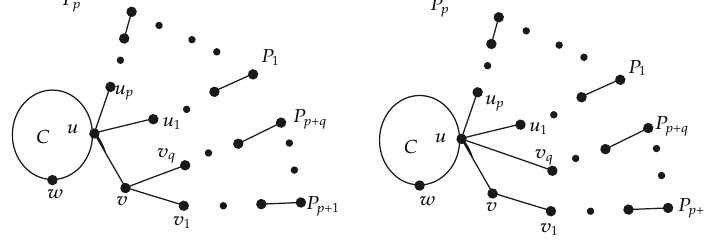
Figure 3: Example of π 3